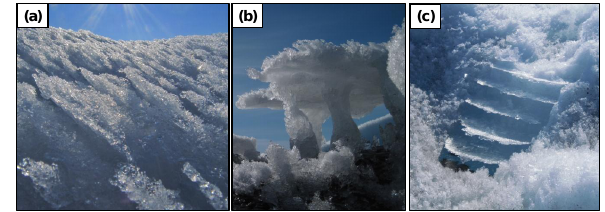
Figure 8. Ice formations arising from radiative melt. (a) “Feath- ers” ca. 5–10cm long, overlying a permeable melt crust a further several centimetres thick. These needed several days of cold, sunny weather to form. (b) “Mushrooms”, approximately 20cm diameter and 15cm tall, which we believe formed from remnants of the pre- vious year’s cryoconite holes. (c) “Stacks” of cryoconite hole lids, formed when the water in the cryoconite hole freezes overnight. Each lid represents the water level that night, then the water level drops during the day as the surrounding ice surface